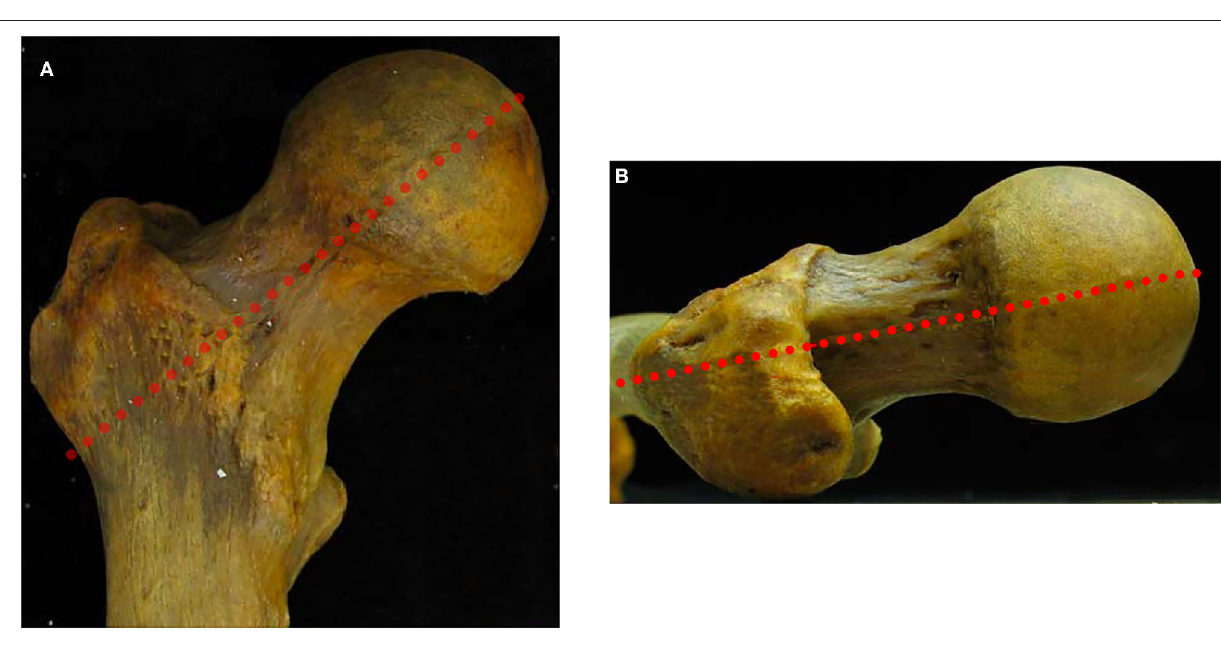
11.9 mm. The largest cam deformity was 35 mm in length, 42 mm in width, and 12 mm in